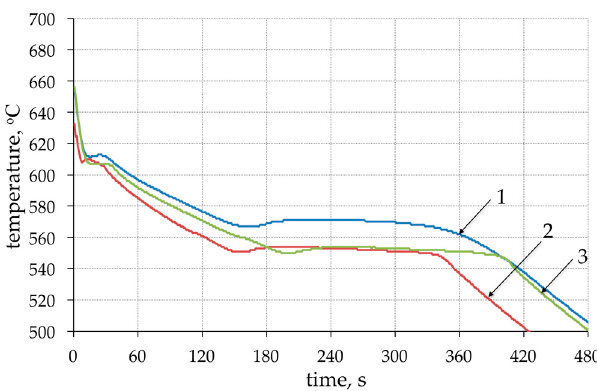
Figure 5. Solidification curves: 1—base AlSi7Mg0.6 alloy, 2—AlSi7Mg0.6 after Ar flow refining, 3—AlSi7Mg0.6 after addition 2 wt % Mg and 0.03 wt % Sr.